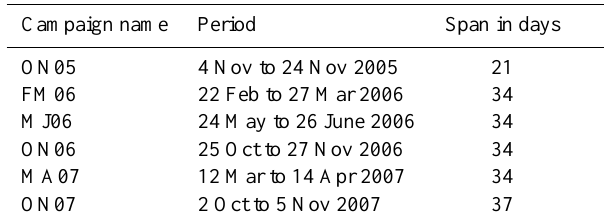
Table 1. ICESat Campaigns available from the National Snow Ice Data Center.